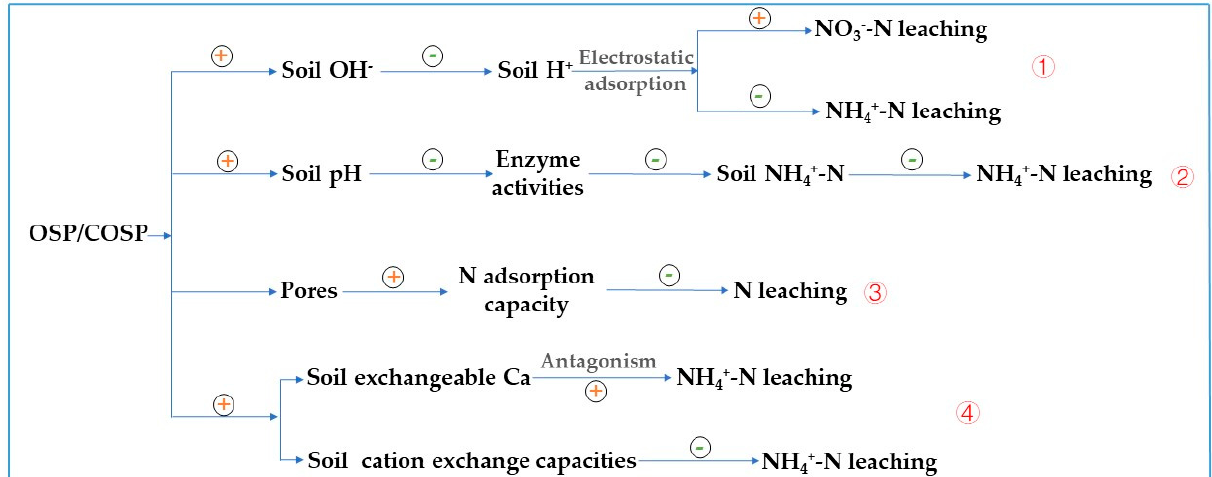
Figure 11. Four mechanisms by which pre- and post-calcined OSP affected N leaching from the latosol. We used four process hypotheses: (1) electrostatic adsorption of ammonium; (2) high pH reduces nitrate reducing enzymes; (3) increased pore volume enhances N-storing capacity; (4) soil cation exchange capacity decreasing ammonium leaching. “+” indicates an increase; “-” indicates a decrease.